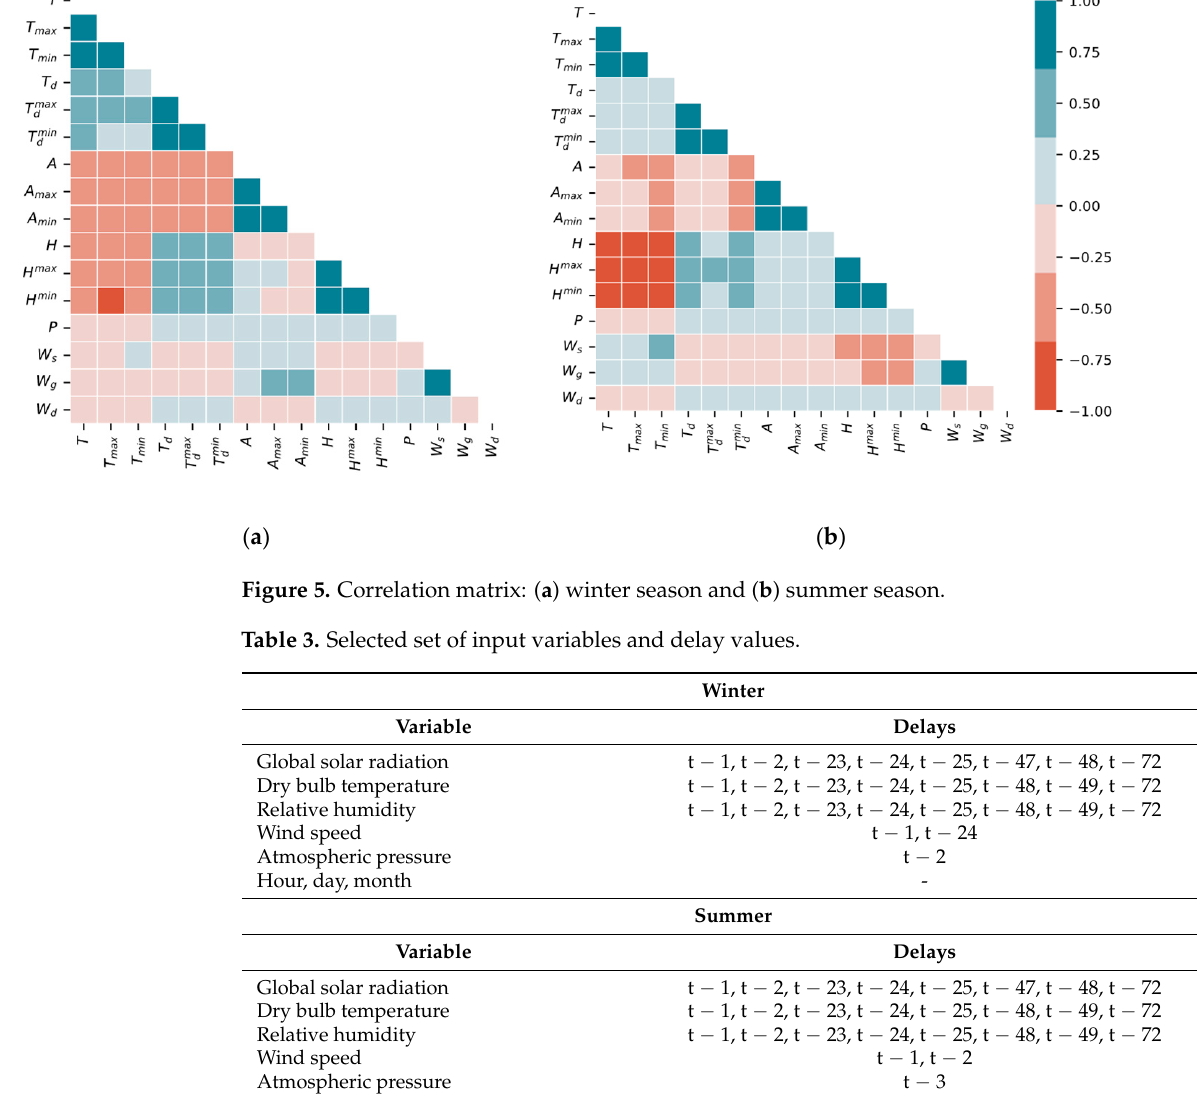
Table 3. Selected set of input variables and delay values.